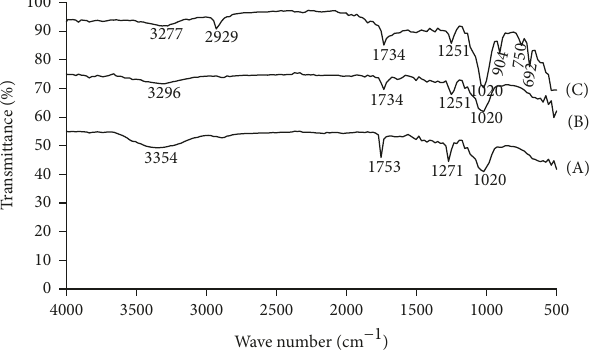
Figure 2: FTIR spectra for RW (A), WPC (B), and WPNC